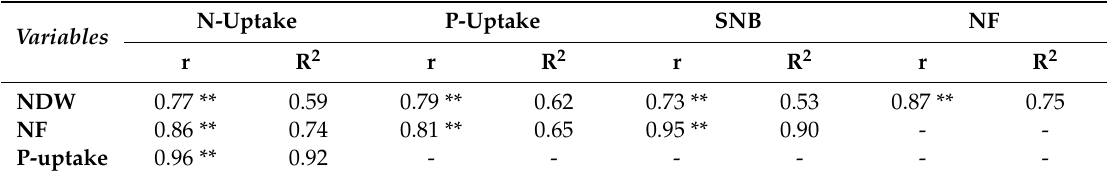
Table 6. Correlation between nodule dry weight and nitrogen fixation and soil nitrogen balance if only grain was removed and nitrogen and phosphorus uptake.